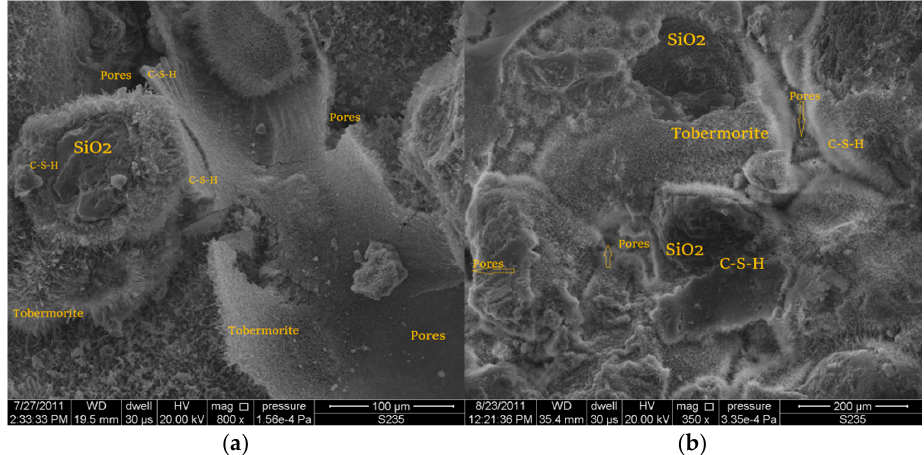
Figure 15. Scanning electron microscope (SEM) photos of the microstructure of silicate bricks: ( a ) the structure of traditional sand–lime products, mag.: 100 μ m; and ( b ) structure of lime-sand products modified with 10% admixture in the form of a mix modifier, mag.: 200 μ m.